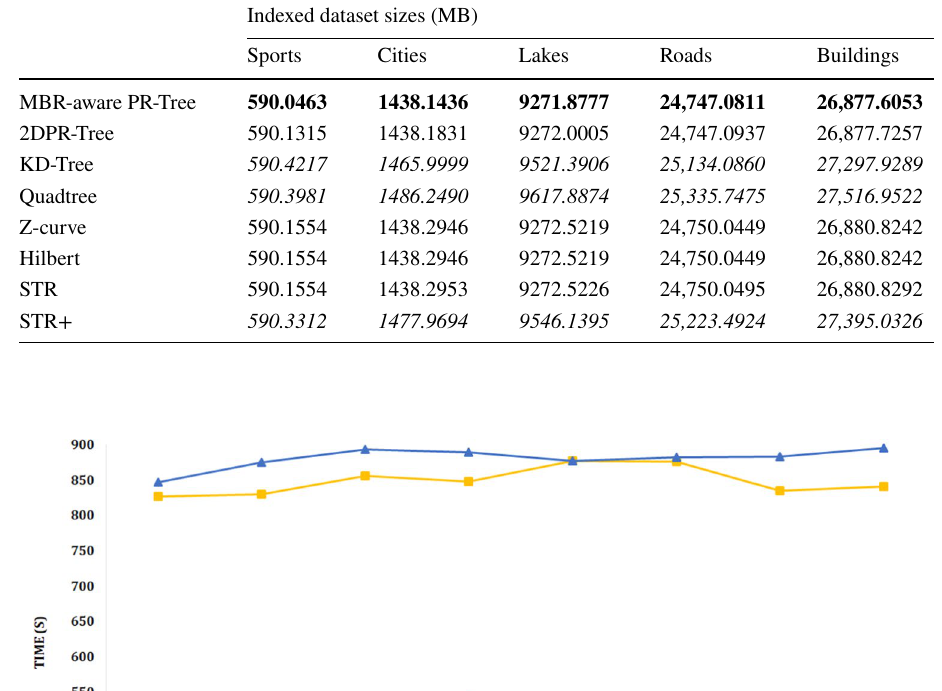
Table 2 Indexed datasets sizes in MB for different techniques